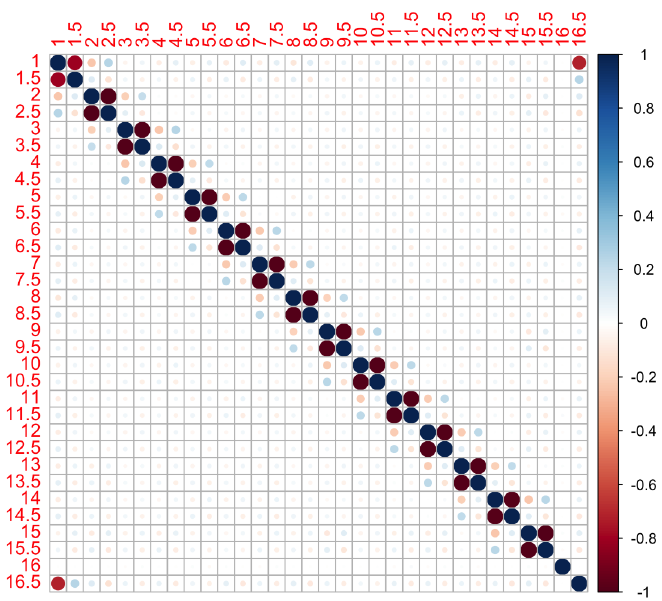
Figure 8 . Correlations among contributions to Im( S ) from integer and half-integer lattice sites. Positive correlations appear as blue dots and negative ones are depicted as red. The size of the dots represents the size of the correlation. Note that the negative correlation between site 1 and sites 1 . 5 and 16 . 5 are not as strong as the other